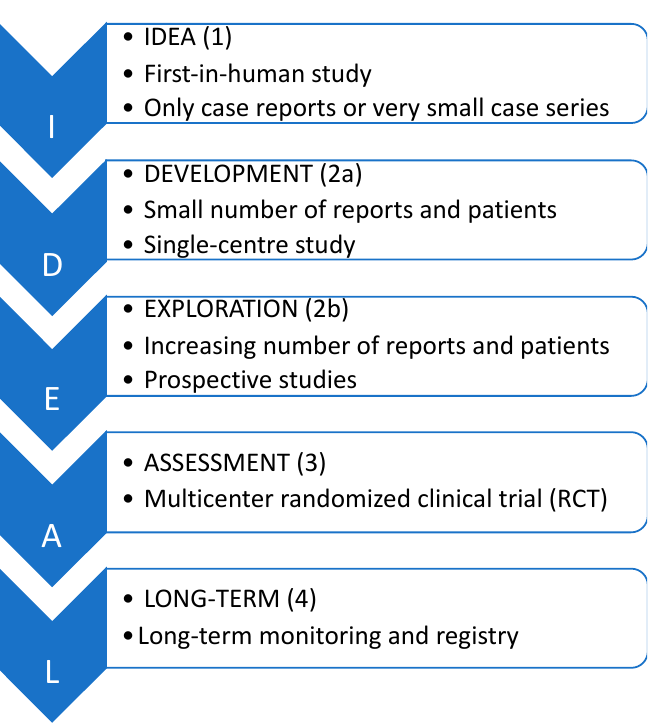
Figure 1. The IDEAL staging system.